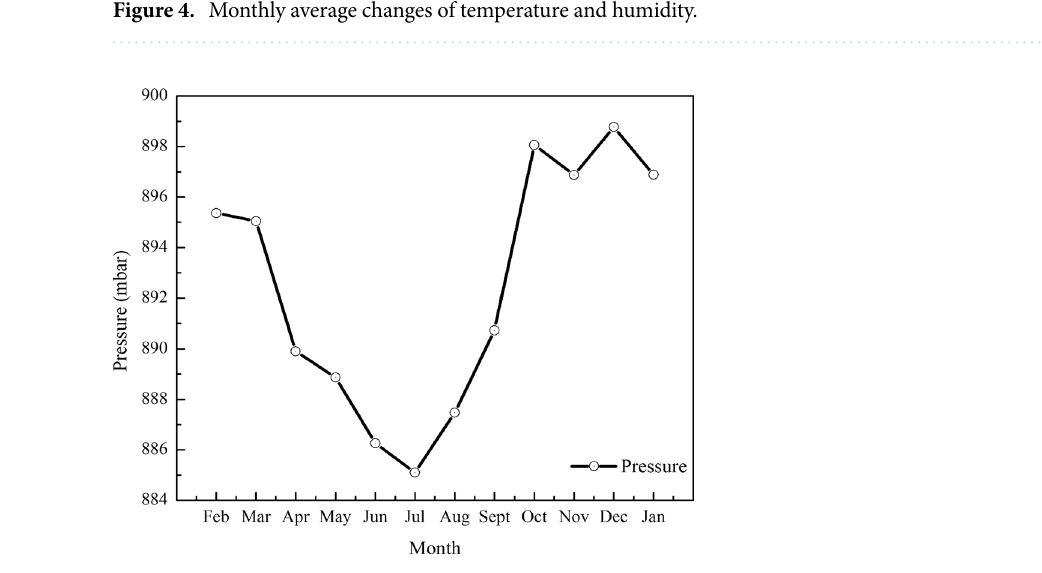
Figure 5. Monthly average variation of atmospheric